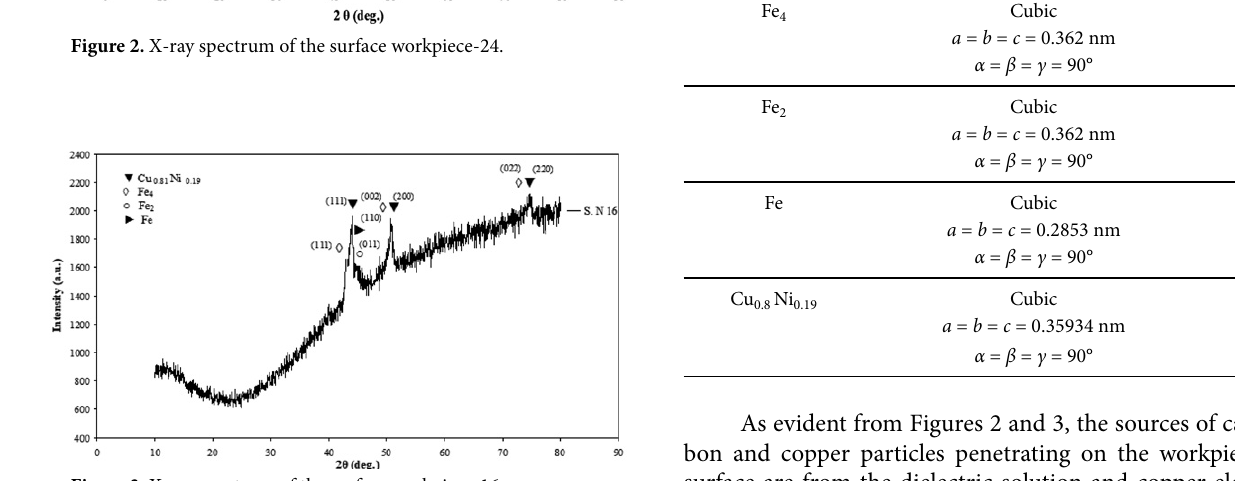
Figure 3. X-ray spectrum of the surface